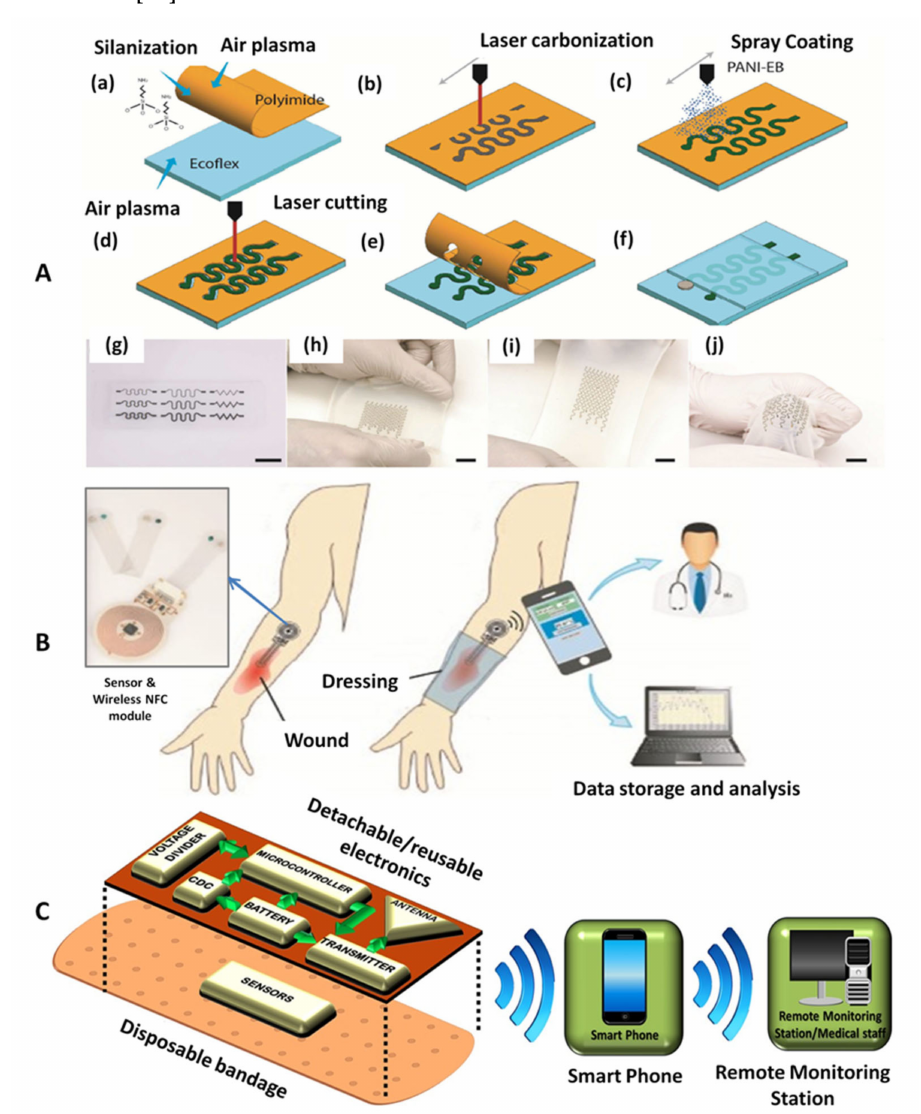
Figure 2. ( A ) Schematic illustrations of the fabrication process and images of the stretchable pH sensor with serpentine interconnects: ( a ) Polyimide (PI) layer fixed on Ecoflex substrate via silanization, ( b ) laser carbonization of carbon traces, ( c ) PANI coating of the carbon traces, ( d ) PI laser treatment, ( e ) excess PI removal, ( f ) Ecoflex insulation of the interconnects and Ag/AgCl and solid electrolyte deposition, ( g ) photograph of various stretchable PANI/C-PI interconnect designs, ( h – j ) images illustrating pH sensors being stretched. Reprinted (adapted) with permission from Reference [71] Copyright 2021 American Chemical Society. ( B ) Flexible wireless wound pH monitoring system using NFC communication. Left: The image presenting wireless NFC module. Reprinted (adapted) with permission from Reference [10]. Copyright 2021 Elsevier. ( C ) The schematic representation of a smart bandage assembly used for pH monitoring. Adapted from Reference